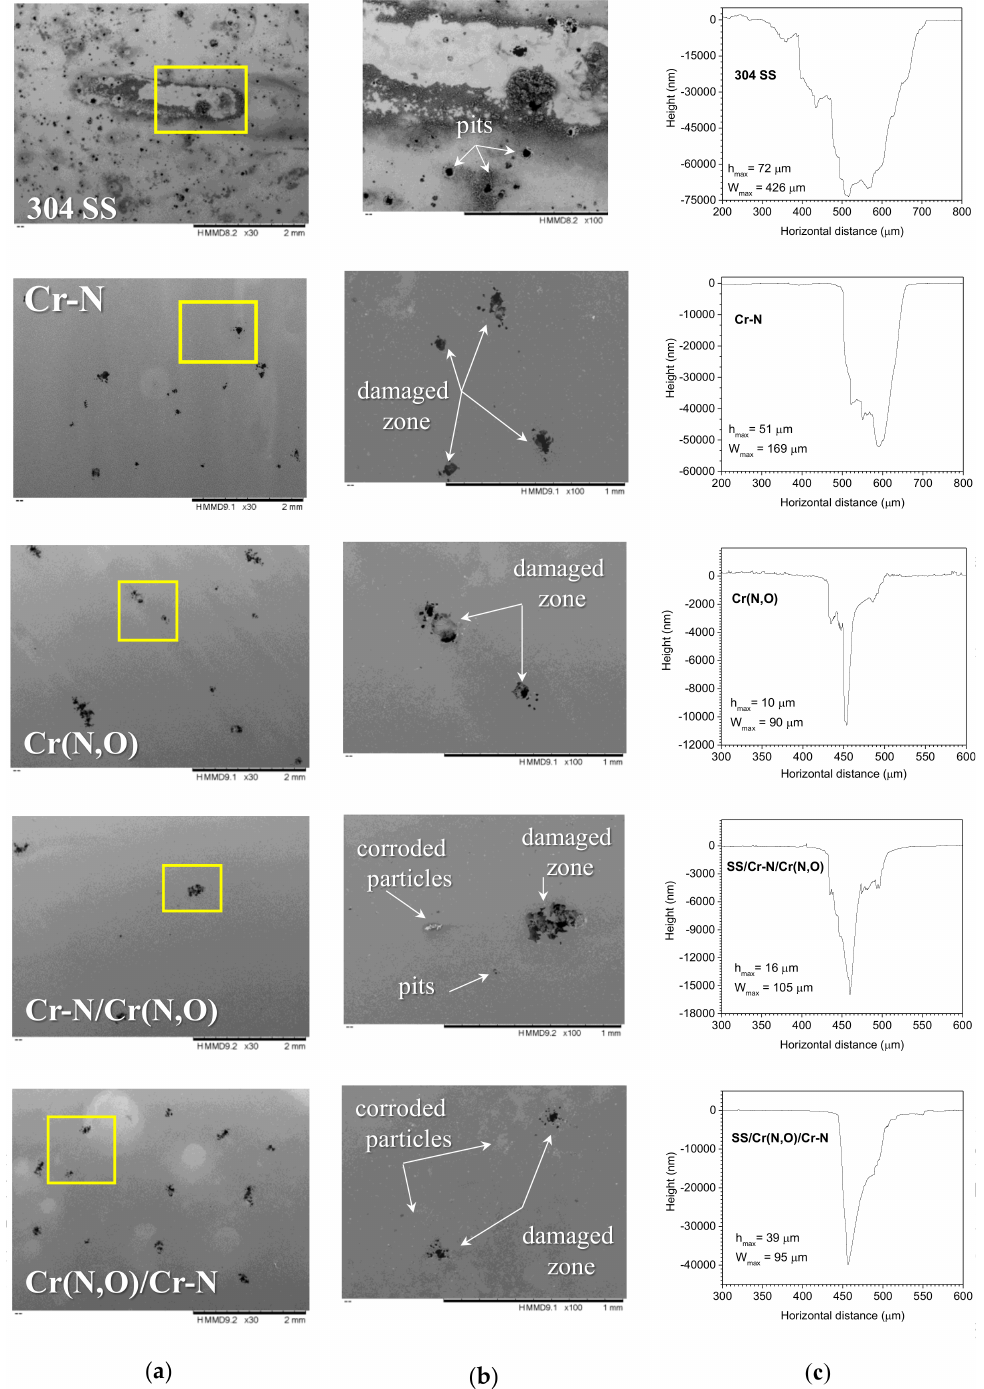
Figure 11. Investigation of the Cr-based coatings surfaces after the corrosion tests: micrographs of: ( a ) SEM micrographs at 30 × magnification; ( b ) SEM micrographs at 100 × magnification; ( c ) profilometry lines on selected